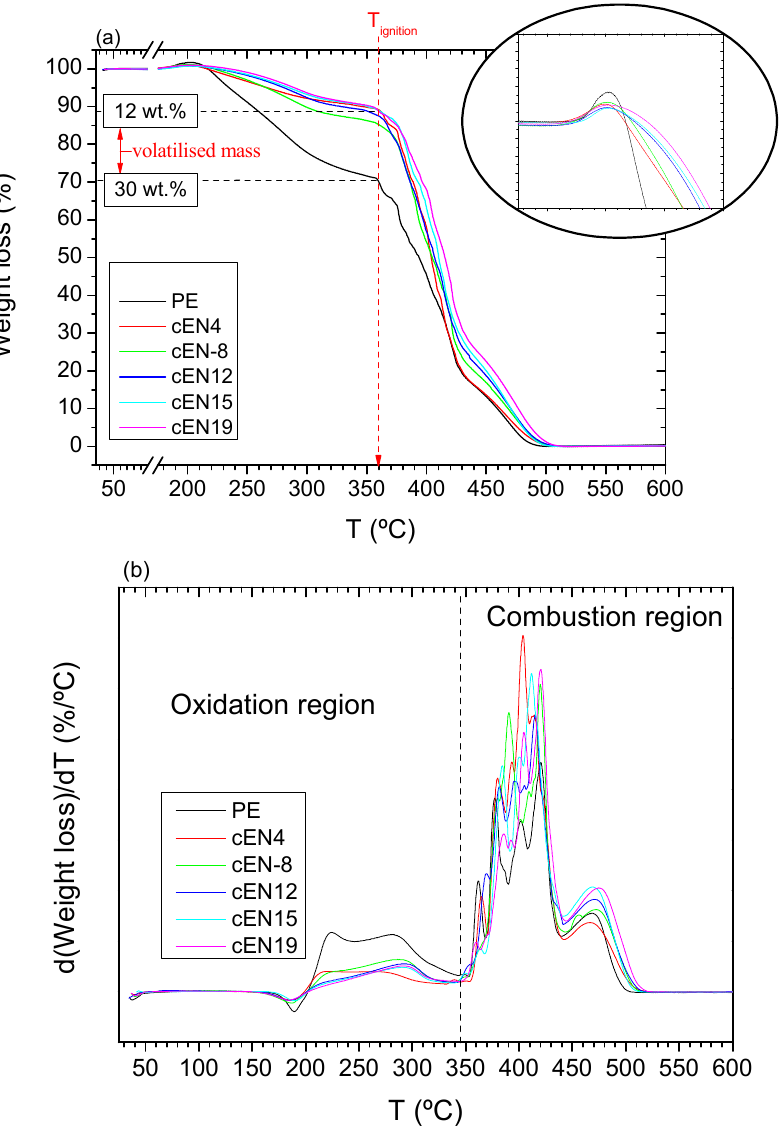
Figure 5. TGA curves ( a ) and DGTA curves ( b ) for all the samples. It is clear that the simple insertion of a low content of norbornene units (sample cEN4) causes the evolution of volatiles to be slowed down, and the fraction of the material involved in the oxidation to be significantly smaller than in the neat PE (see 12 wt% vs 30 wt%), as indicated in Figure 5a. Accordingly, the oxygen take-up preceding the weight